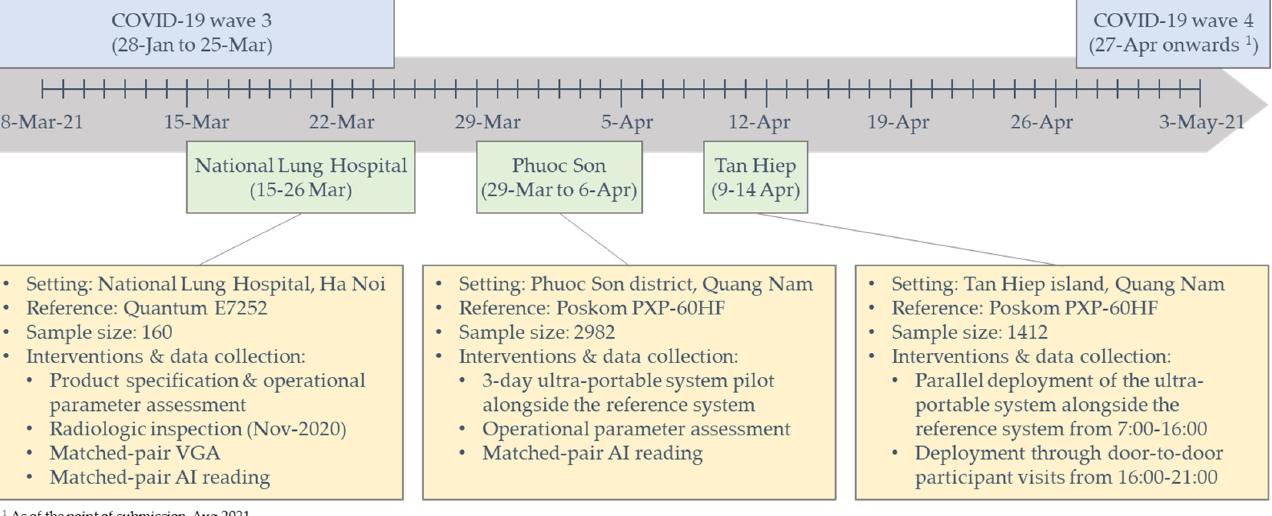
Figure 1. Illustration of study timeline, interventions and activities.